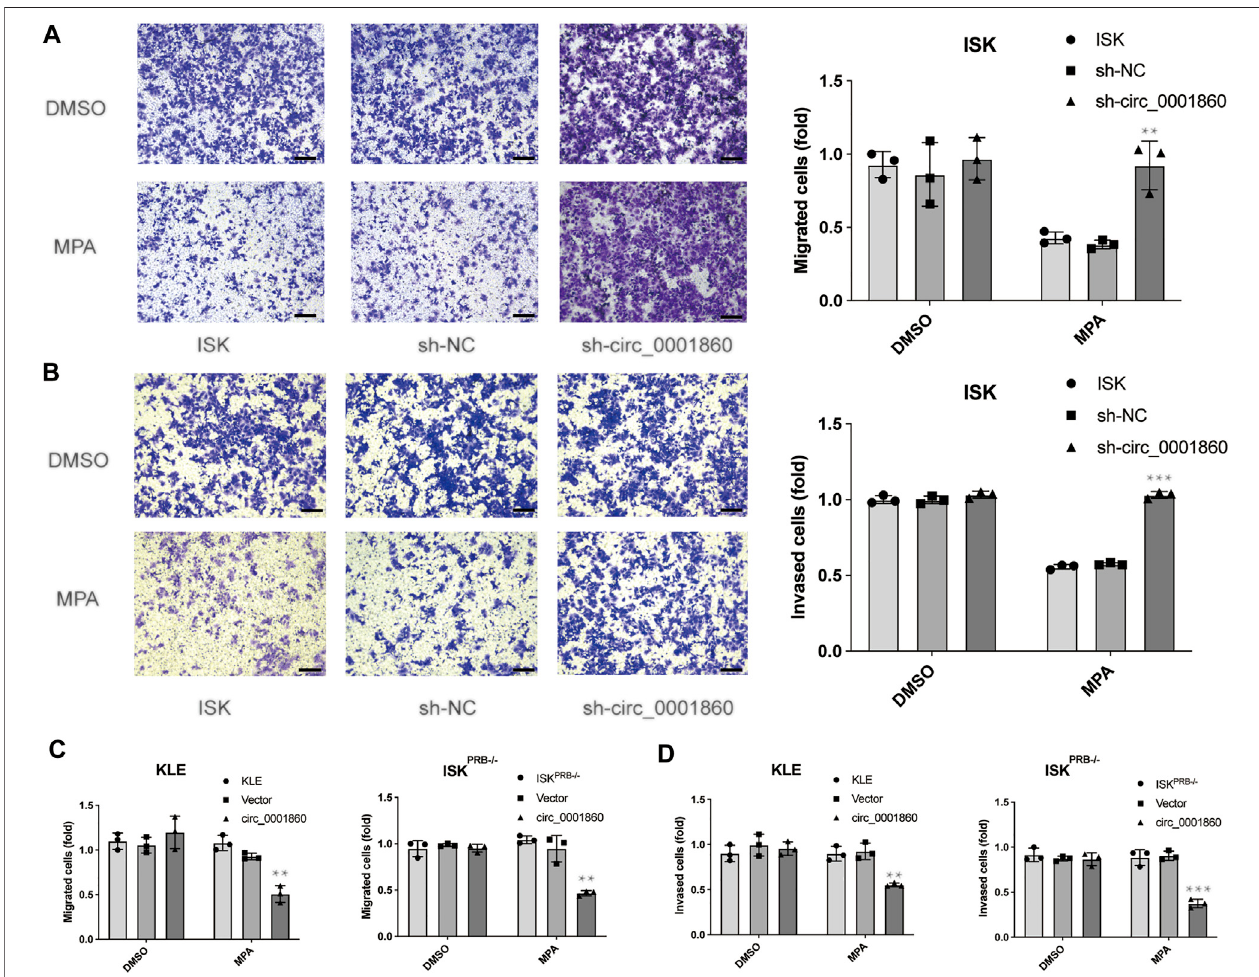
FIGURE 4 | The effect of hsa_circ_0001860 on MPA sensitivity in migration and invasion of endometrial cancer cells. (A) Representative pictures and bar graphs showing the effect of hsa_circ_0001860 knockdown on MPA-induced alteration of ISK migration (magni fi cation, × 100; scale bars (cid:2) 100 μ m). (B) Representative picturesandbargraphsshowingtheeffectofhsa_circ_0001860knockdownonMPA-inducedalterationofISKinvasion(magni fi cation, × 100;scalebars (cid:2) 100 μ m). (C, D) Overexpression of hsa_circ_0001860 in MPA-resistant ISK PRB − / − and KLE restored MPA sensitivity. * p < 0.05, ** p < 0.01, *** p < 0.001.